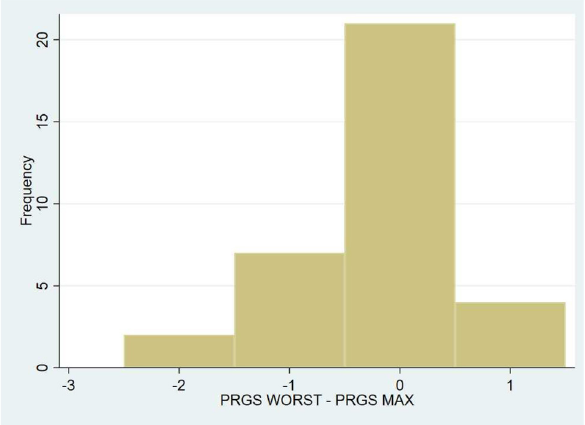
Figure 1: Difference in maximal peritoneal regression grading score (PRGS) between clips marked quadrant biopsies and the peritoneal metastasiswithvisuallymostmalignantfeatures(WB)atthesecond pressurized intraperitoneal aerosol chemotherapy